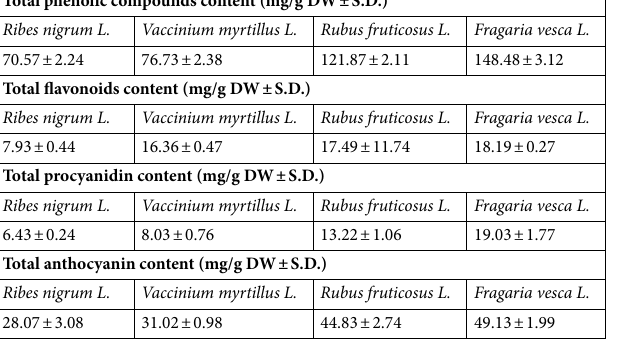
Table 1. Total content of phenolic compounds, flavonoids, anthocyanins and procyanidins in leaf extracts of R. nigrum L., V. myrtillus L., R. fruticosus L. and F. vesca L . expressed as mg/g DW (dry weight). Values are mean of three replicate determinations (n = 3) ± SD.